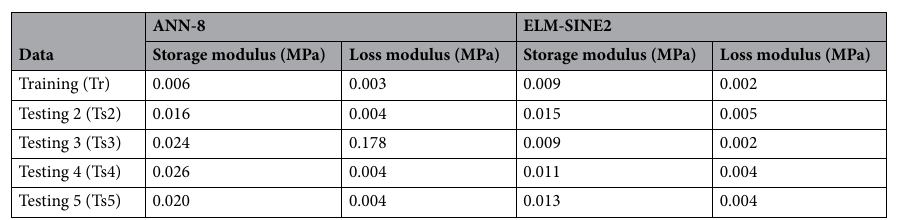
Table 7. The RMSE value for each data